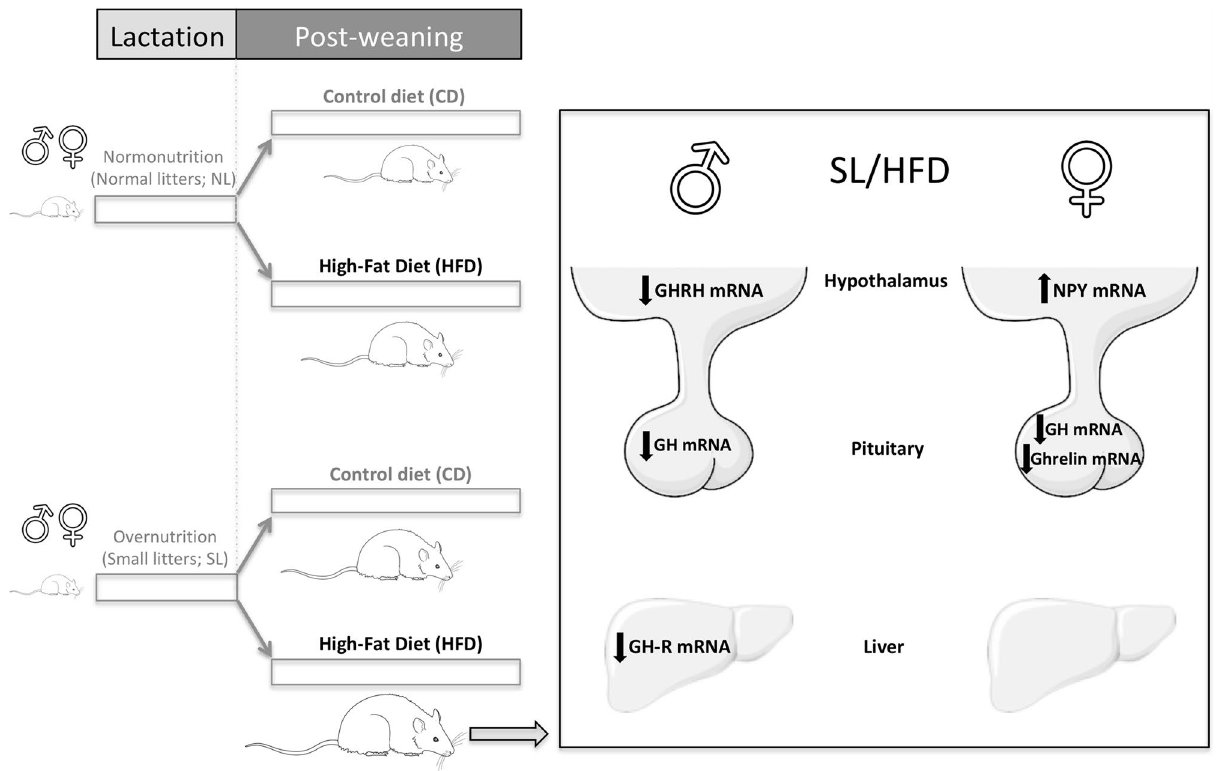
Figure 5. Graphical summary of the most salient alterations in key elements of the GH axis caused by the obesogenic insults, SL (rearing in small litters) and HFD (exposure to high fat content diet from weaning onwards), in male and female rats, with particular focus on the impact of combined exposure to these obesogenic insults and sexually-divergent perturbations. The figure was created by the authors, using free medical images obtained from Servier Medical Art (https ://smart .servi